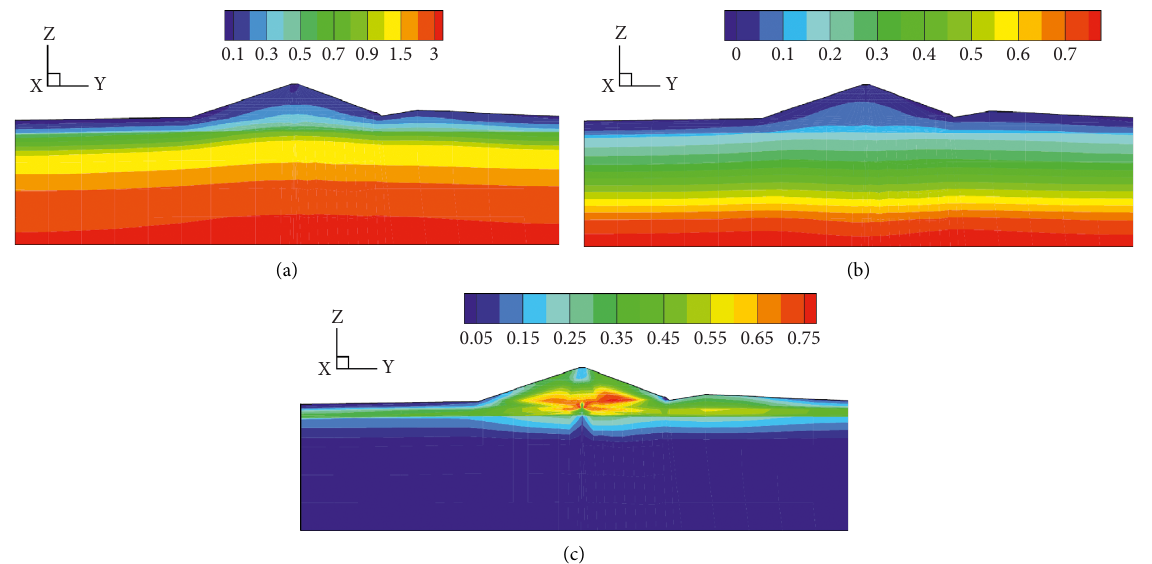
Figure 6: Cloud map of stress distribution of dam under the normal storage water level condition (MPa): (a) major principal stress; (b) minor principal stress; (c) total stress.